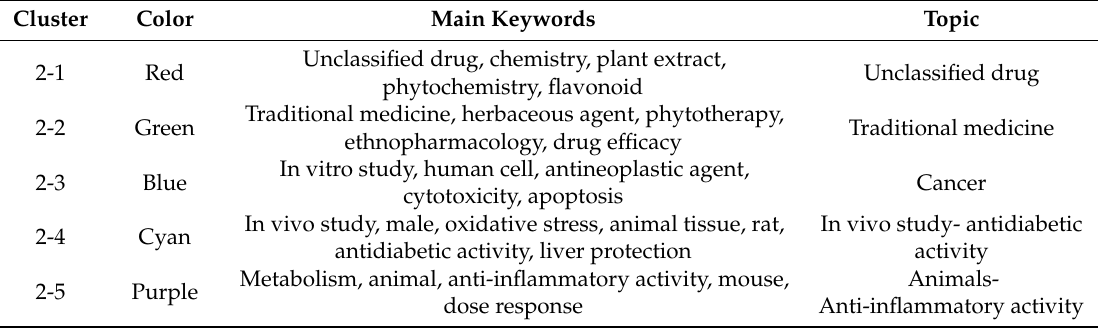
Table 7. Main keywords used by the communities detected in the topic in the period 2015–2019. Cluster Color Main Keywords Topic Unclassified drug, chemistry, plant extract, Unclassified 2-1 Red phytochemistry, flavonoid